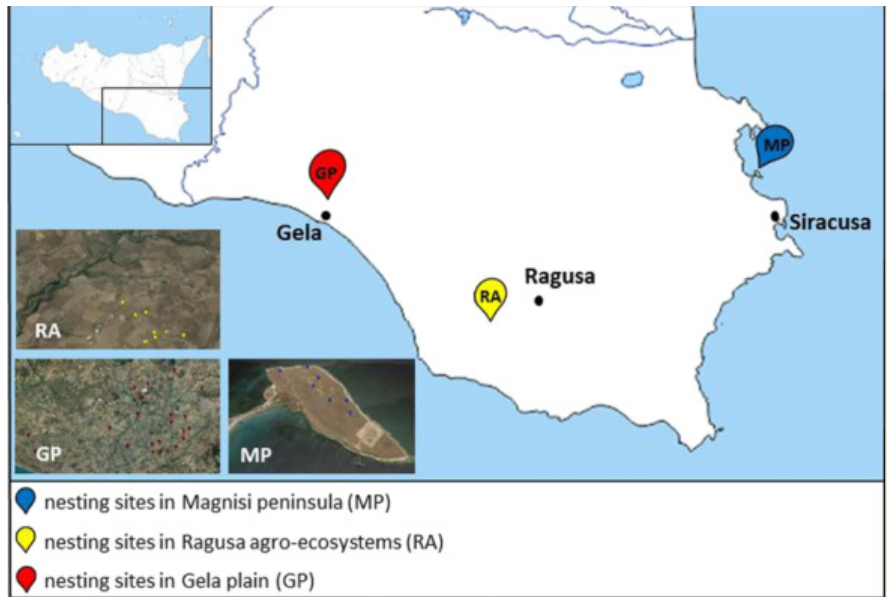
Figure 5. Map of the sampling sites in south-eastern Sicily. MP: Magnisi peninsula; RA: Ragusa agro- ecosystem; GP: Gela plain.